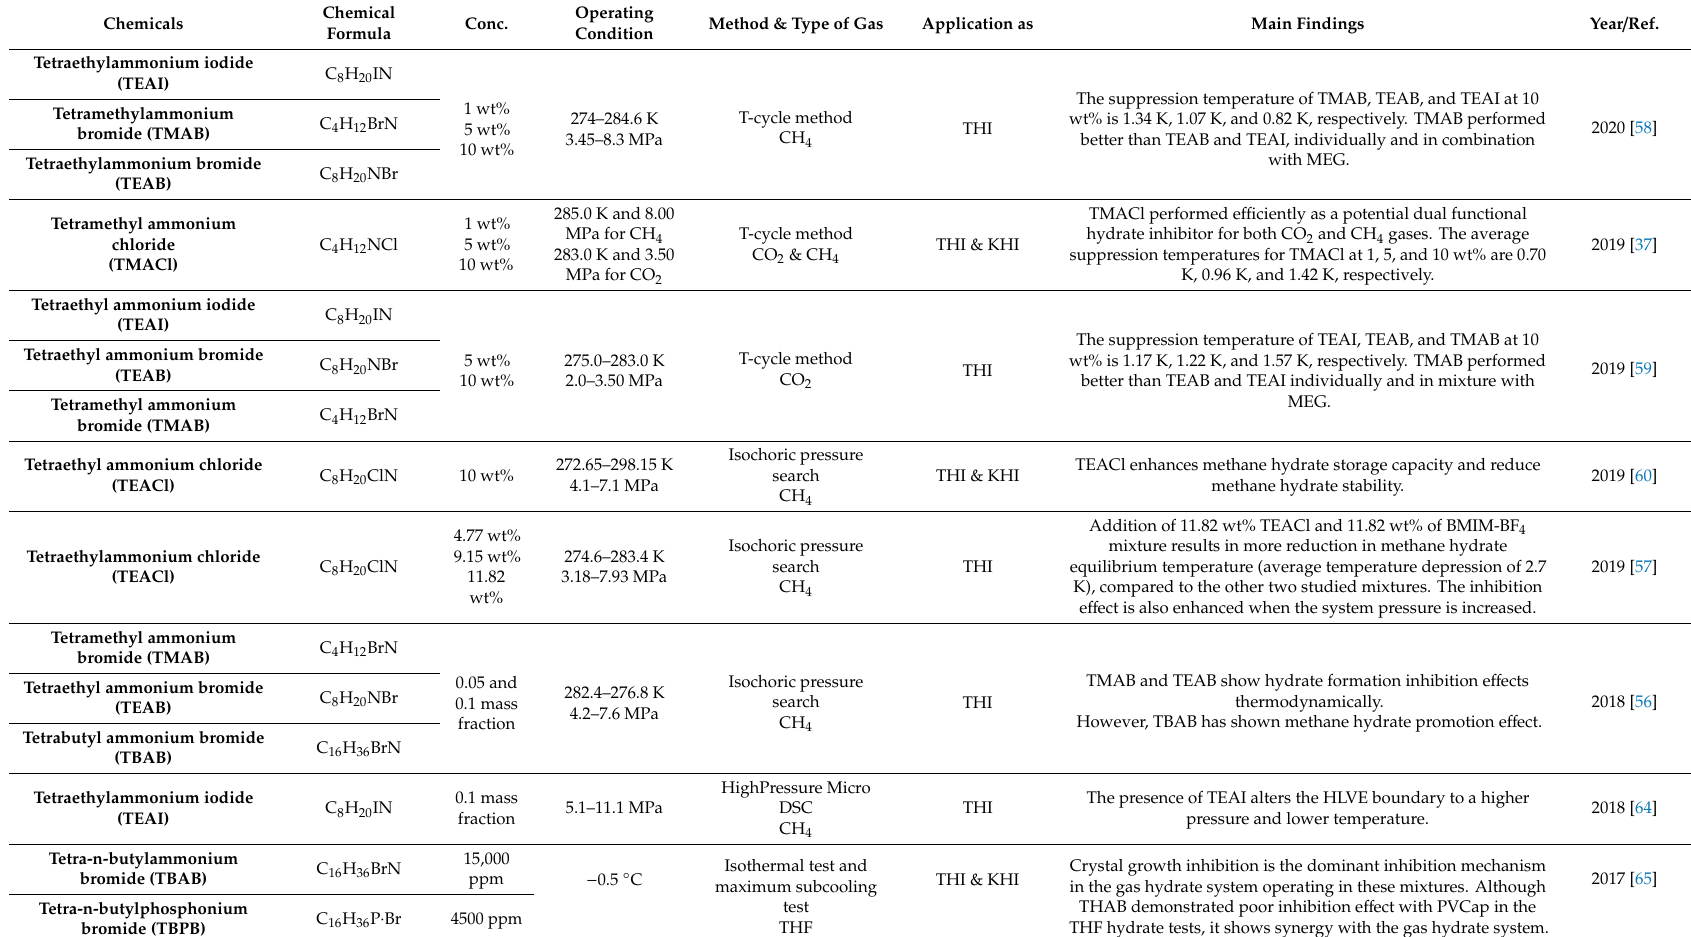
Table 1. Summary of studies conducted on ammonium based ionic liquids for gas hydrate